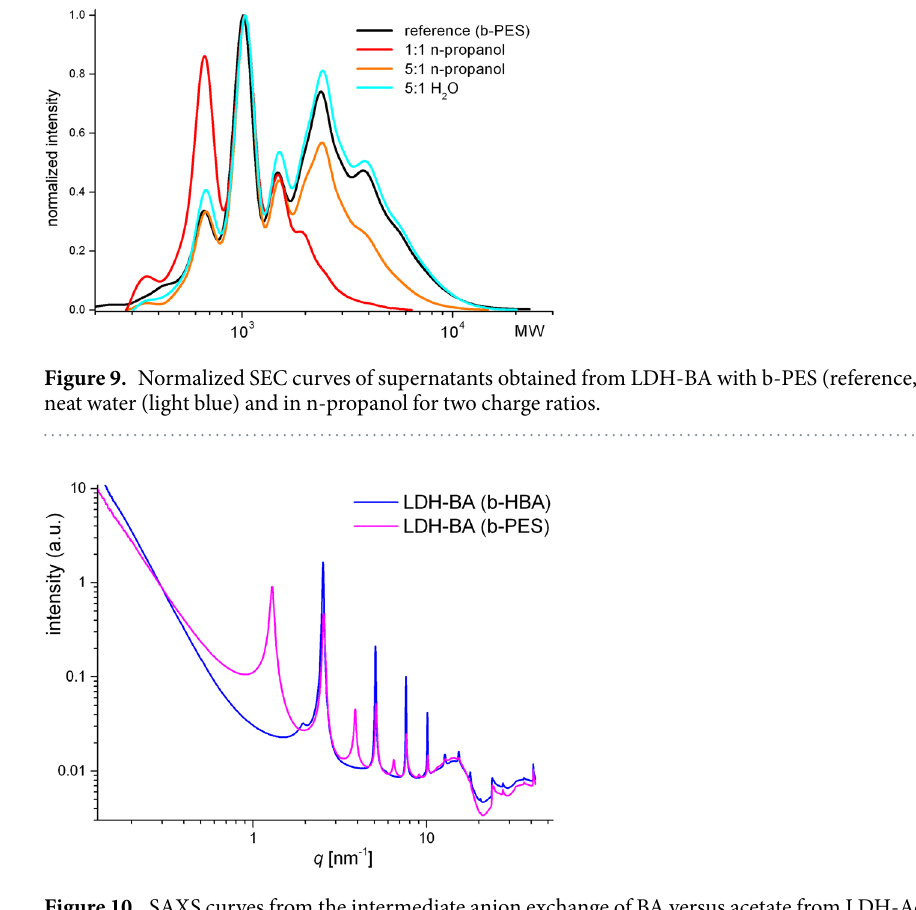
Figure 10. SAXS curves from the intermediate anion exchange of BA versus acetate from LDH-Ac in n-propanol using 1:1 charge ratios (BA carboxylate to layer